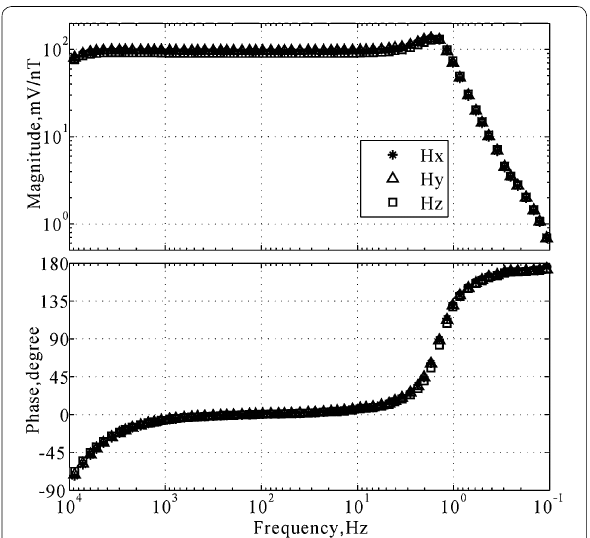
Fig. 7 Triaxial induction coil calibration results. The frequency response of the coil is calculated using the data logger. The flat bandwidth is from approximately 1 Hz to 10 kHz, and the sensitivity is 100 mV/nT. The sensitivity homogeneity errors among the three induction coils are 1.0, 1.2, and 1.3%, and the phase mean square deviations are 2.1, 2.5, and 2.3%